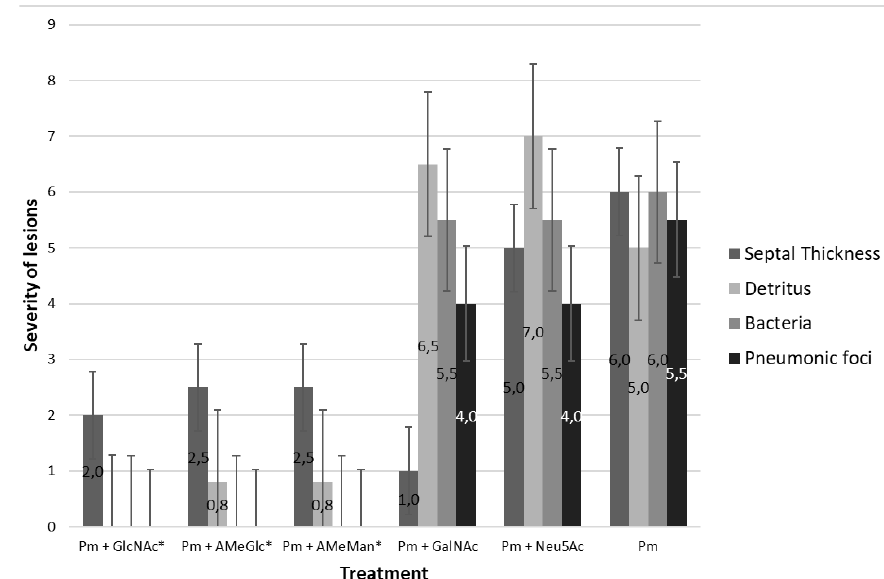
Figure 5. Degree of severity of microscopic lesions in rabbit lung parenchyma in the groups treated with P. multocida + individual carbohydrates and with P. multocida alone (*P<0.05). P. multocida (Pm) , N-acetylglucosamine (GIcNAc), alphamethyglucoside (AMeGIc), alphamethylmannoside (AMeMan), N-acetylgalactosamine (GalNAc) or sialic acid